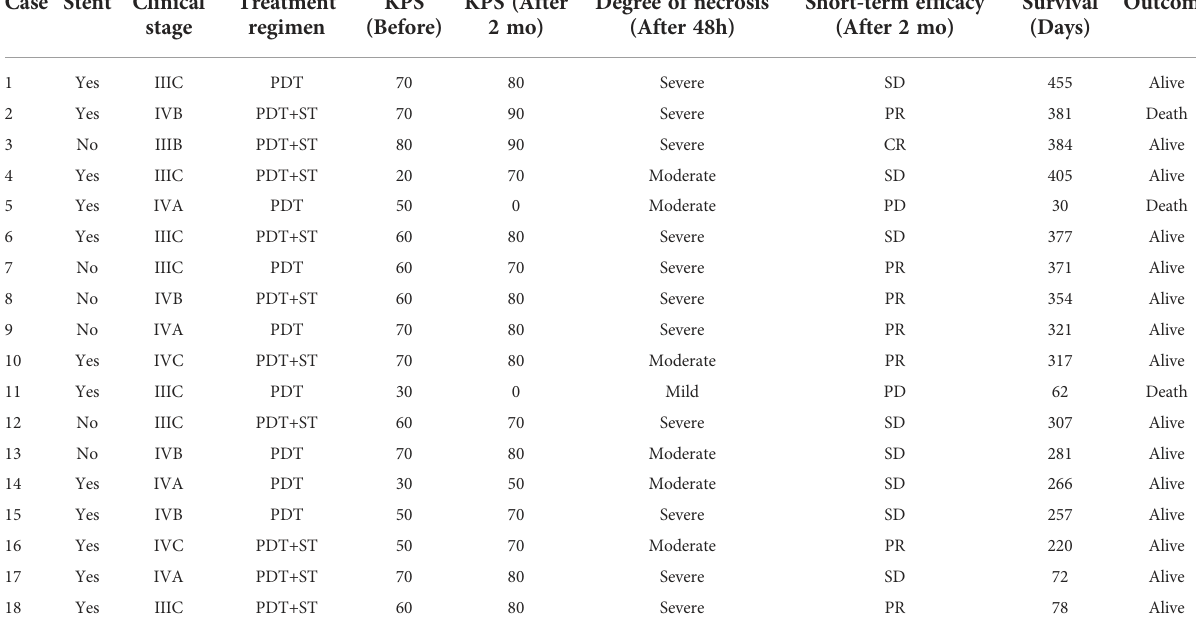
TABLE 2 Clinical data for the eighteen CRC patients undergoing PDT. Case Stent Clinical Treatment stage